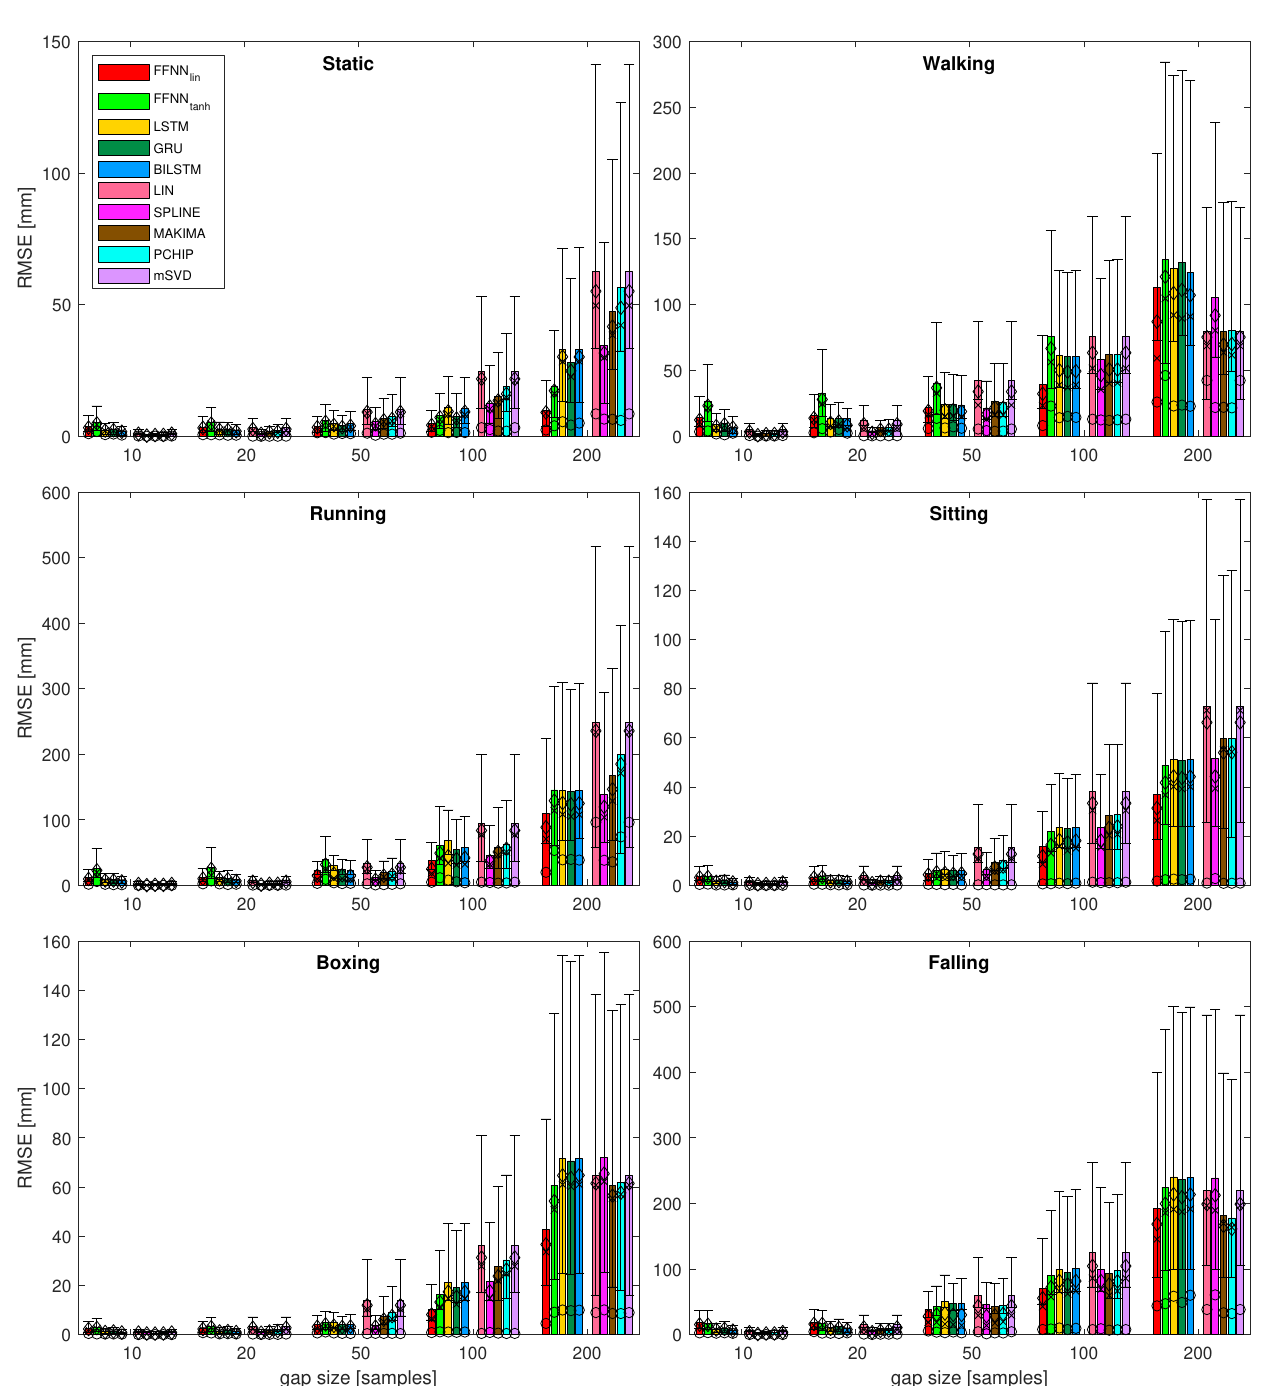
Figure 7. Results for most of the quality measures for all the test sequences. Bars denote RMSE ; for RMSE k : (cid:5) denotes mean value, × denotes median, ◦ denotes mode, whiskers indicate IQR; standard deviation is not depicted here; dash-outlined areas are zoomed in Figure